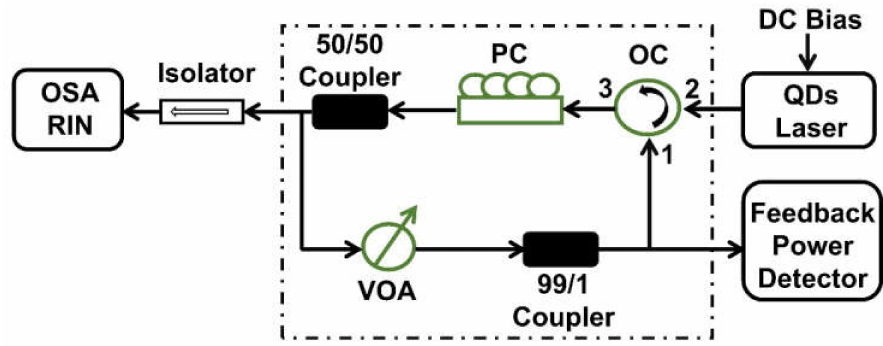
Figure 1. Schematic diagram of the coherent optical feedback